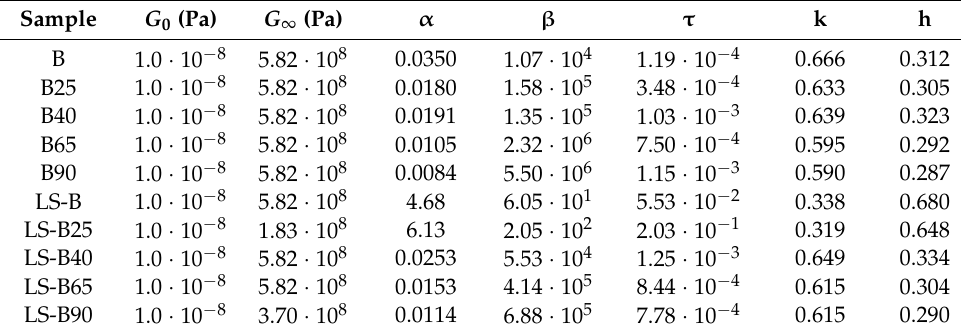
Figure 7. AMWD at different aging times for the LS-B binder. Table 3. The 2S2P1D model’s